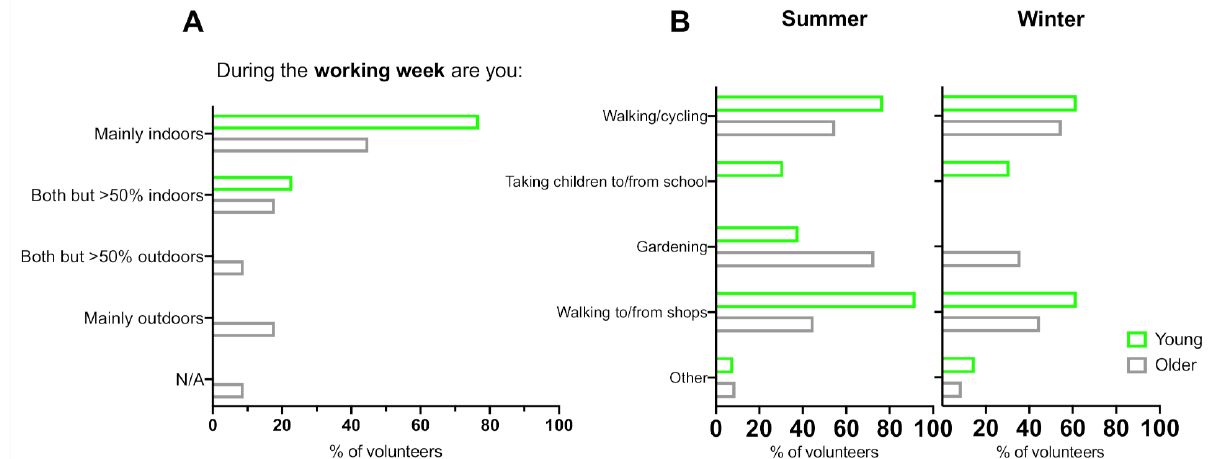
Figure 1. ( A ) Percentage responses of younger and older volunteers who consider themselves to spend time during the working week: mainly indoors, mainly outdoors, or both, but >50% indoors or >50% outdoors; ( B ) percentage responses of younger and older volunteers’ activities during the working week when outdoors for short regular periods in summer and winter (multiple choice question).